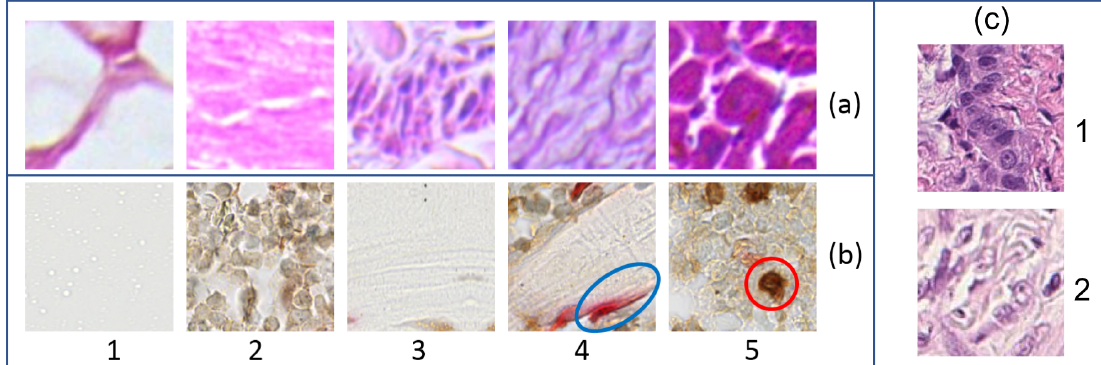
Figure 3. Additional histological datasets (examples of annotated patches). ( a ) Cardiovascular tissue dataset : (1) loose connective tissue, (2) smooth muscle of muscular artery, (3) smooth muscle of the large vein, (4) smooth muscle of the elastic artery, and (5) cardiac muscle of the heart. ( b ) Bone tissue dataset : (1) regions with no clinical interest, (2) parenchyma, (3) hydroxyapatite, (4) osteoclasts (the